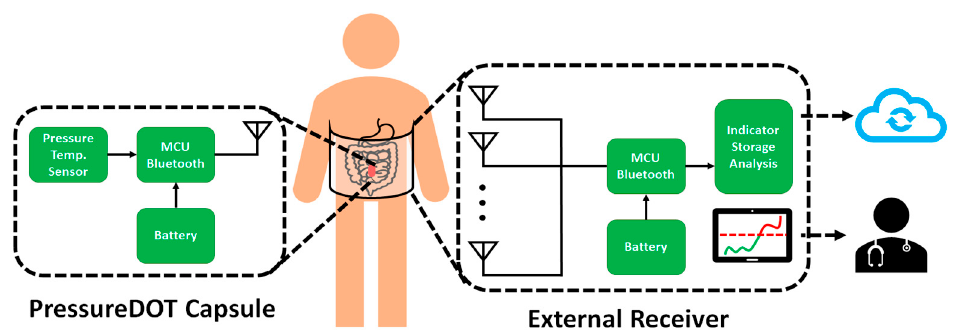
Figure 1. Illustration of the wireless sensor system, PressureDot, which is composed of two parts, an ingestible electronic capsule and a external receiver, that detect continuous changes in intraabdominal pressure in real time. After the external receiver obtains the signal from the capsule, the data can be sent to health providers and is collected in a cloud-based databank.